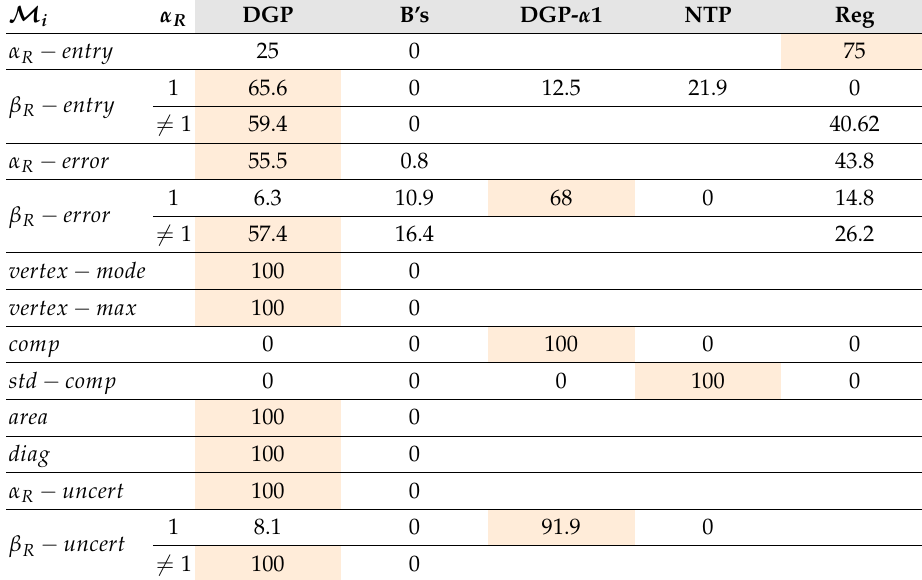
Table 7. Orderings of the algorithms